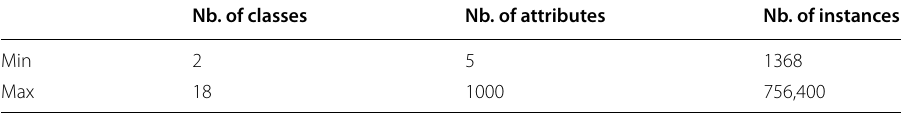
Table 1 Dataset’s dimensions Nb. of